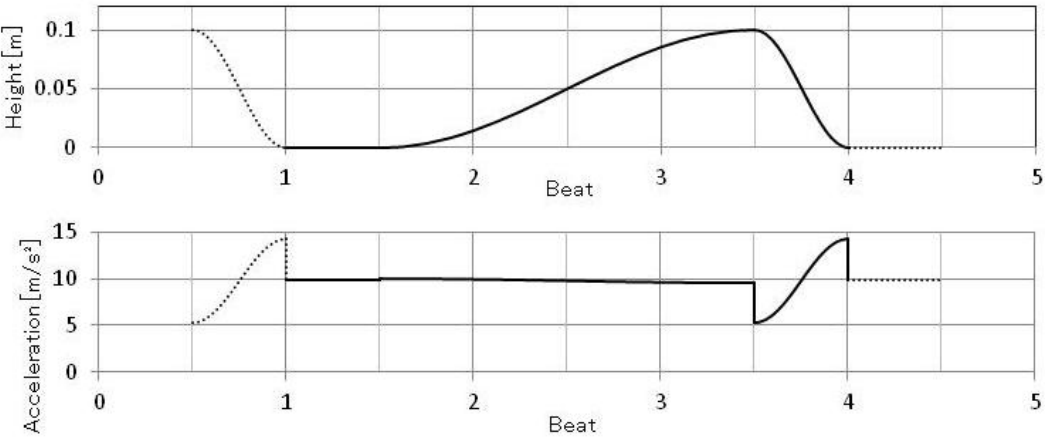
Figure 1. Rise and Fall of 1–3 of Natural Turn in the Waltz. The upper graph shows the height and the lower graph shows its acceleration in vertical direction. The dotted lines show an example of preceding and following